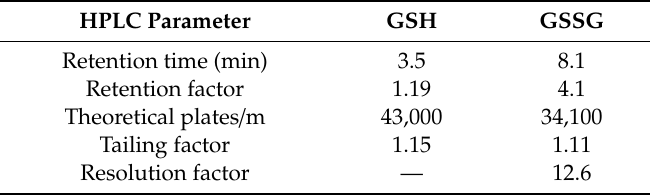
Table 2. A representative chromatogram from a standard GSH / GSSG solution can be found in Figure 2. Table 2. HPLC figures of merit for the separation of GSH /